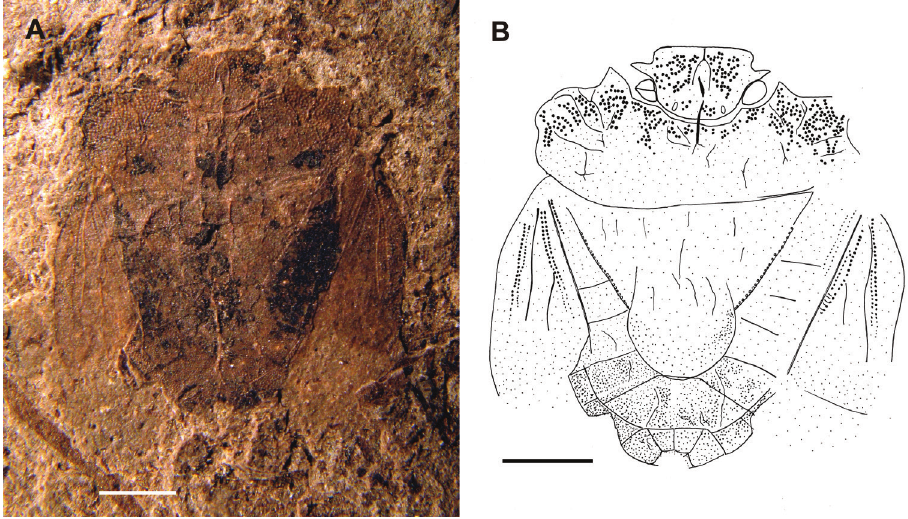
Figure 1. Habitus of Acanthocephalonotum martinsnetoi gen. n. et sp. n. Holotype specimen MAPBAR 4137 A Photograph B line drawing. Scale bars represent 1 mm.